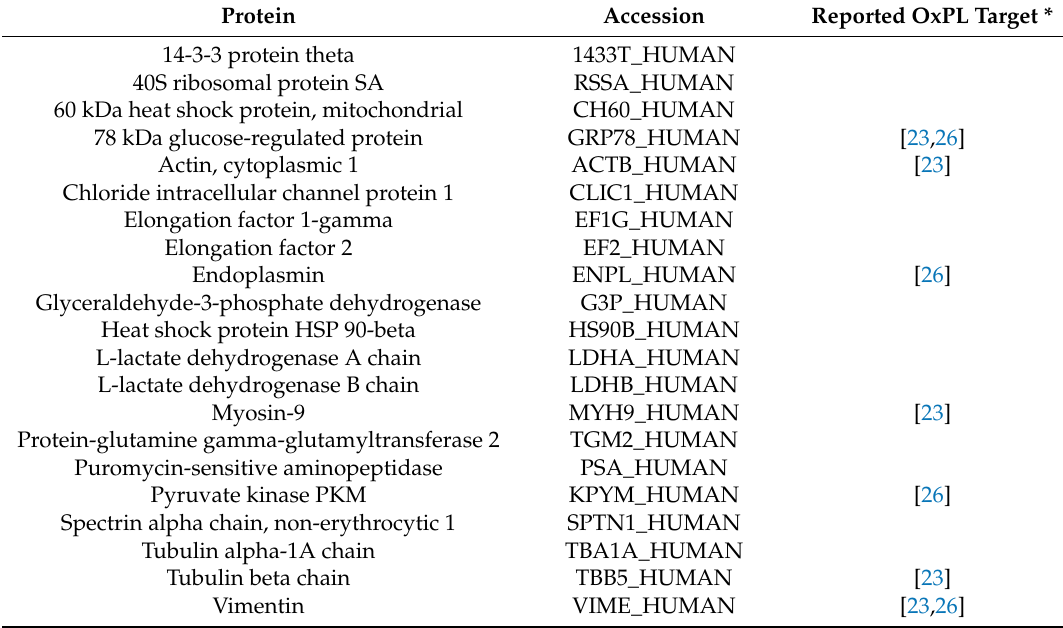
Table 1. Potential OxPAPC target proteins identified from the PBS-soluble fraction.